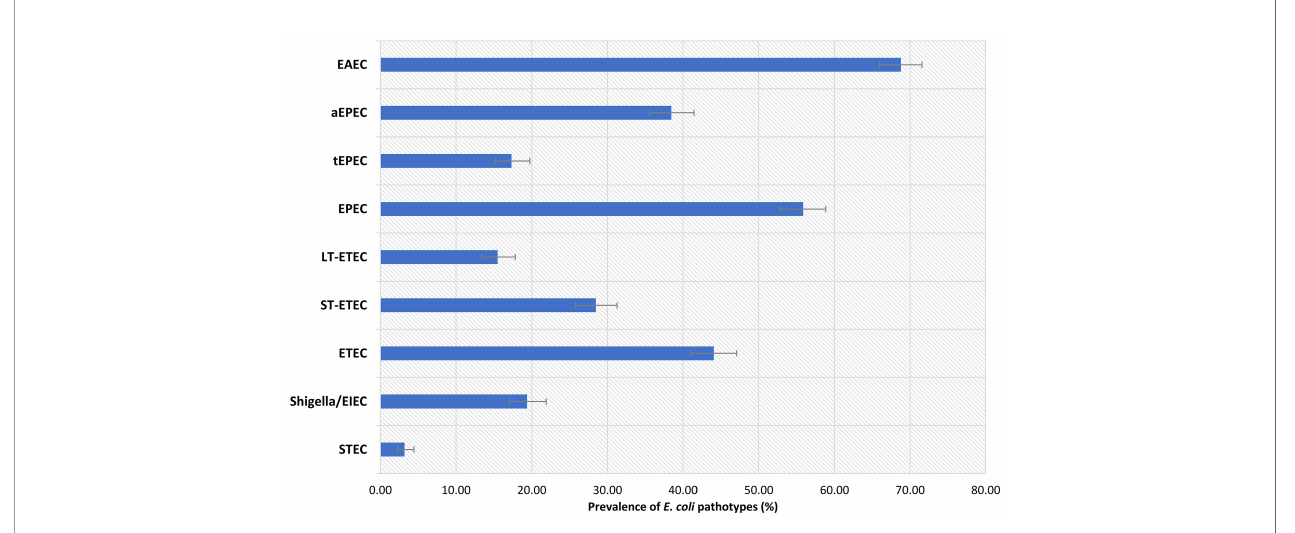
FIGURE 1 | Prevalence of E. coli pathotypes among the participants.